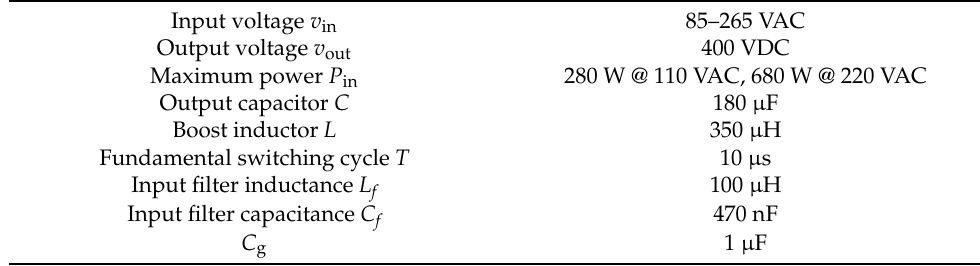
Table 1. Main specifications of the prototype.